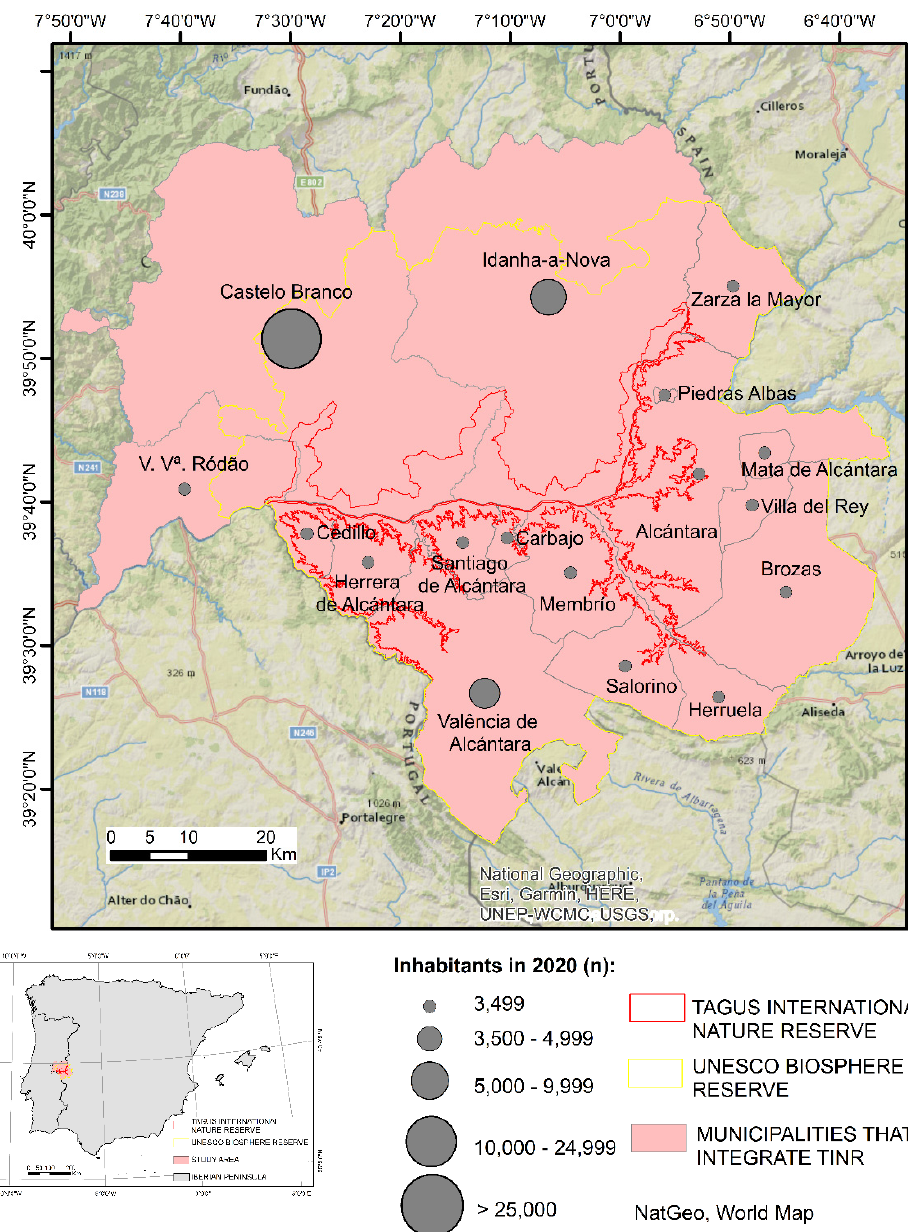
Figure 1. Localization and characterization of study area. Source: Authors’ own elaboration.